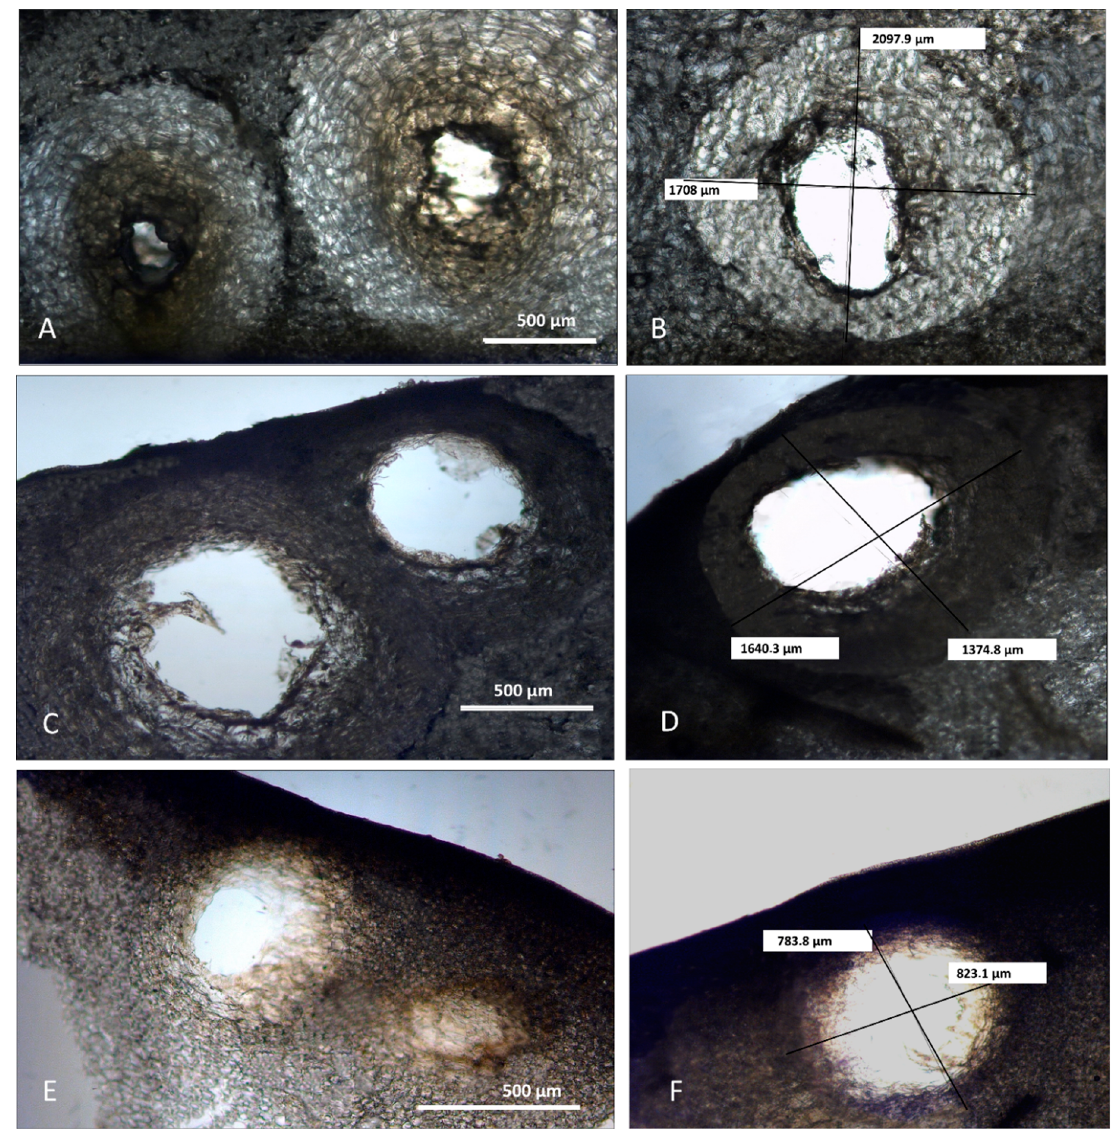
Figure 2. Light microscopy captures of oil glands from the peel of C. limon , C. × bergamia , and C. × myrtifolia , commonly known respectively as lemon, bergamot, and chinotto. Sub-prolate secretory cavities of C. limon ( A , B ). Oil glands sub-oblate to oblate-spheroidal in shape from the epicarp of C. × bergamia ( C , D ) and C. × myrtifolia ( E , F ). As shown by polar and equatorial diameter measures ( B , D , F ), lemon oil glands are larger and more oval with respect to those of bergamot and chinotto.